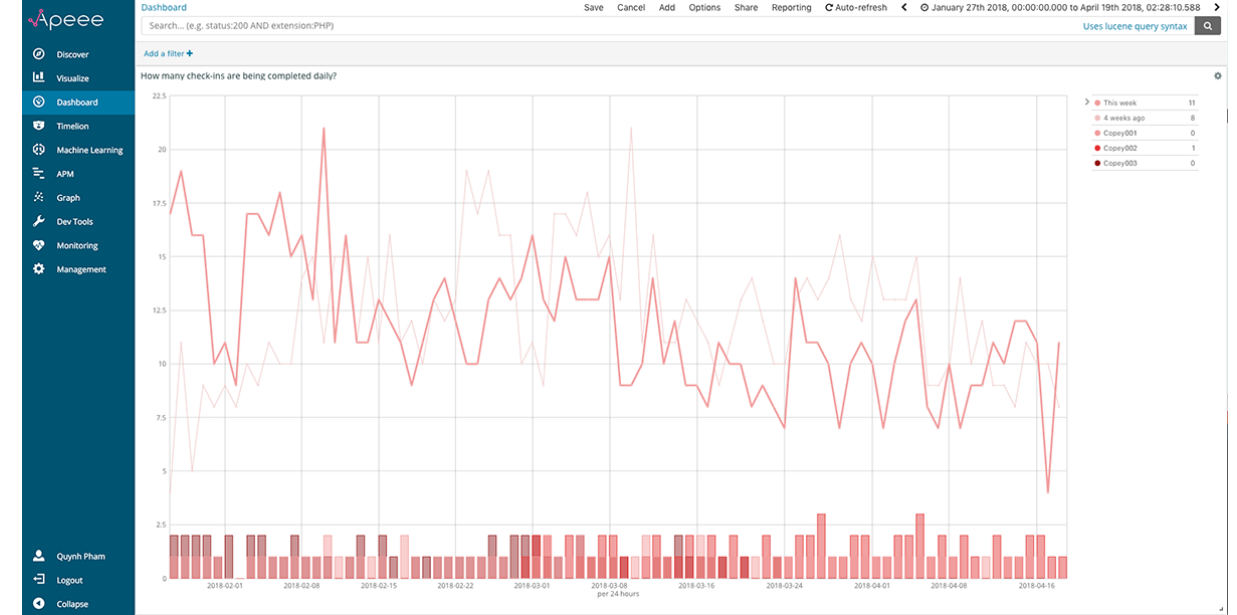
Figure 7. The analytic indicator for “how many check-ins are being completed daily?,” visualized through APEEE as a histogram with 3 layered graphs. APEEE: Analytics Platform to Evaluate Effective